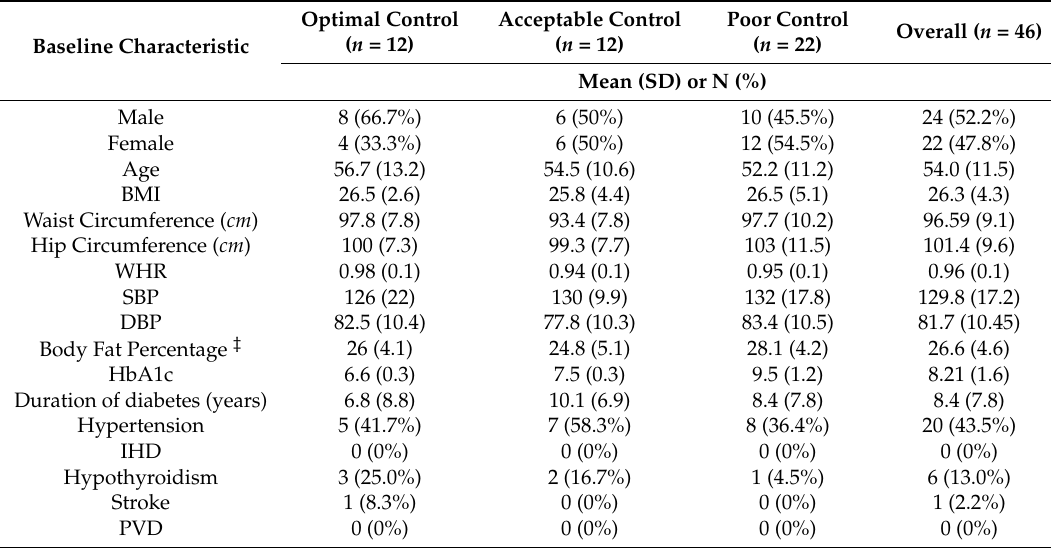
Table 3. Baseline characteristics: Age, gender, years since diagnosis, complications, etc., by glycemic control status